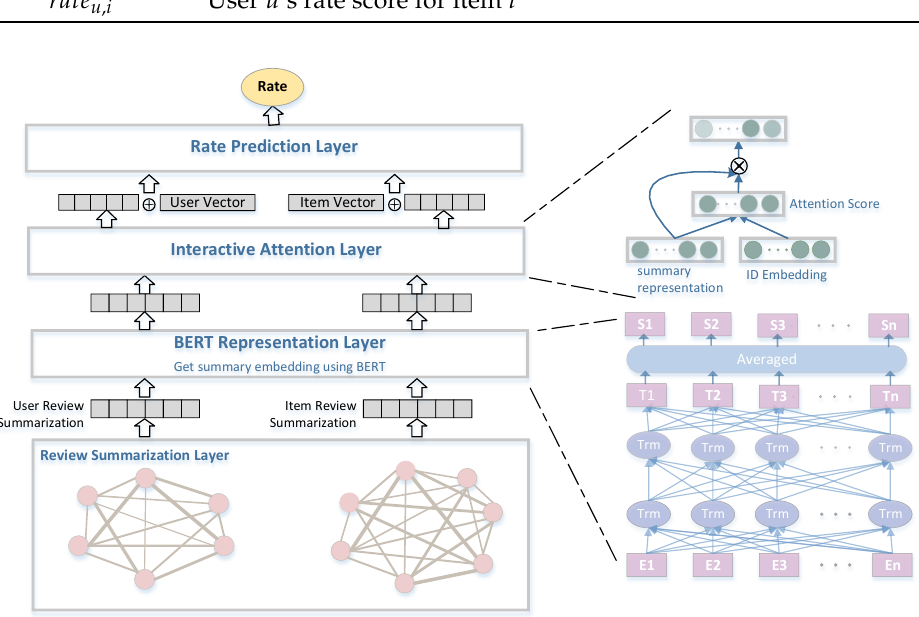
Figure 1. A Joint Summarization and Pre-Training model for Recommendation